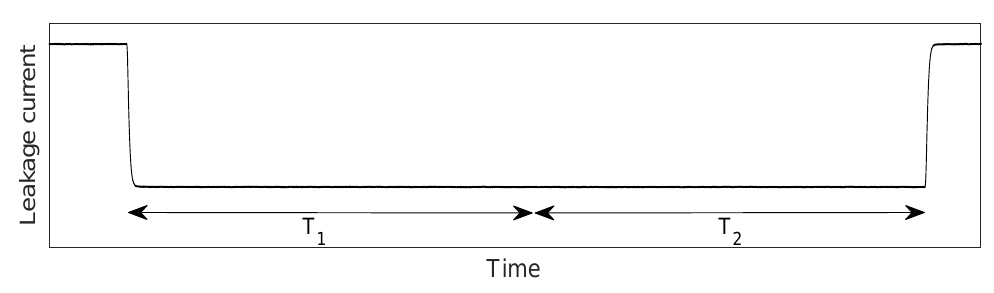
Figure 9: Sample measurement illustrating the procedure. At the beginning of T 1 the clock is stopped, all values in T are ignored. Then all values measured in T 1 to a singular value representative for amount of static